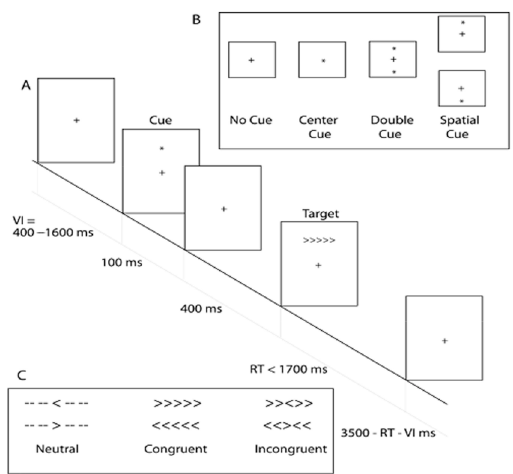
Figure 1. An illustration on ANT. ( A ) A single trial including three stages ( B ) 4 cue conditions: No Cue, Central Cue, Double Cue, and Spatial Cue ( C ) 3 target conditions: Neutral, Congruent, and Incongruent. Reprinted with permission from Ref.